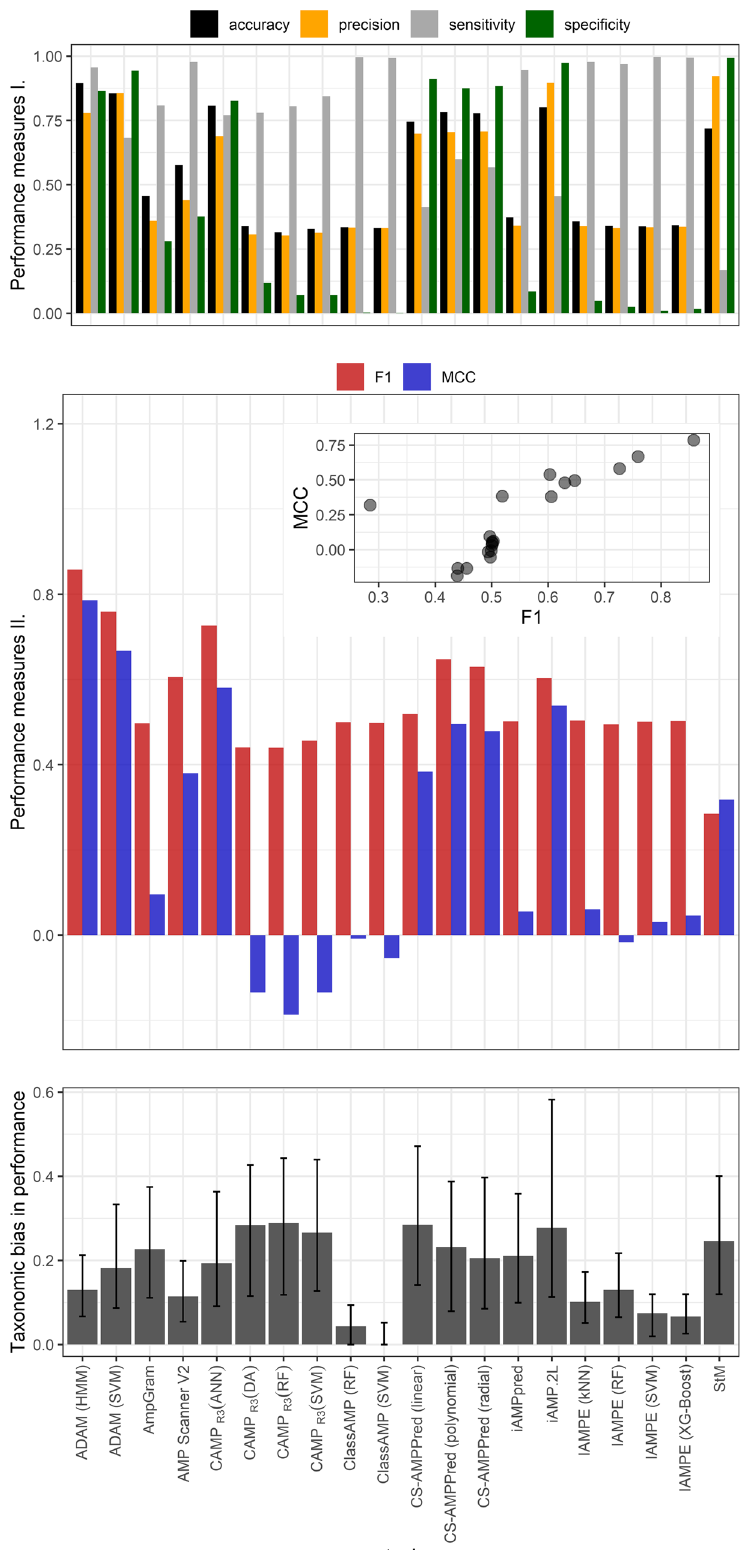
Figure 1. Classical performance measures (top panel), F 1 scores and Matthew’s correlation coefficient (MCC; middle panel), and taxonomic bias in performance assessed as median of the distances in MCC scores between taxa, within a given prediction tool (bottom panel; see “Methods” for details); black segments on the bottom panel represent the value range between the first and third